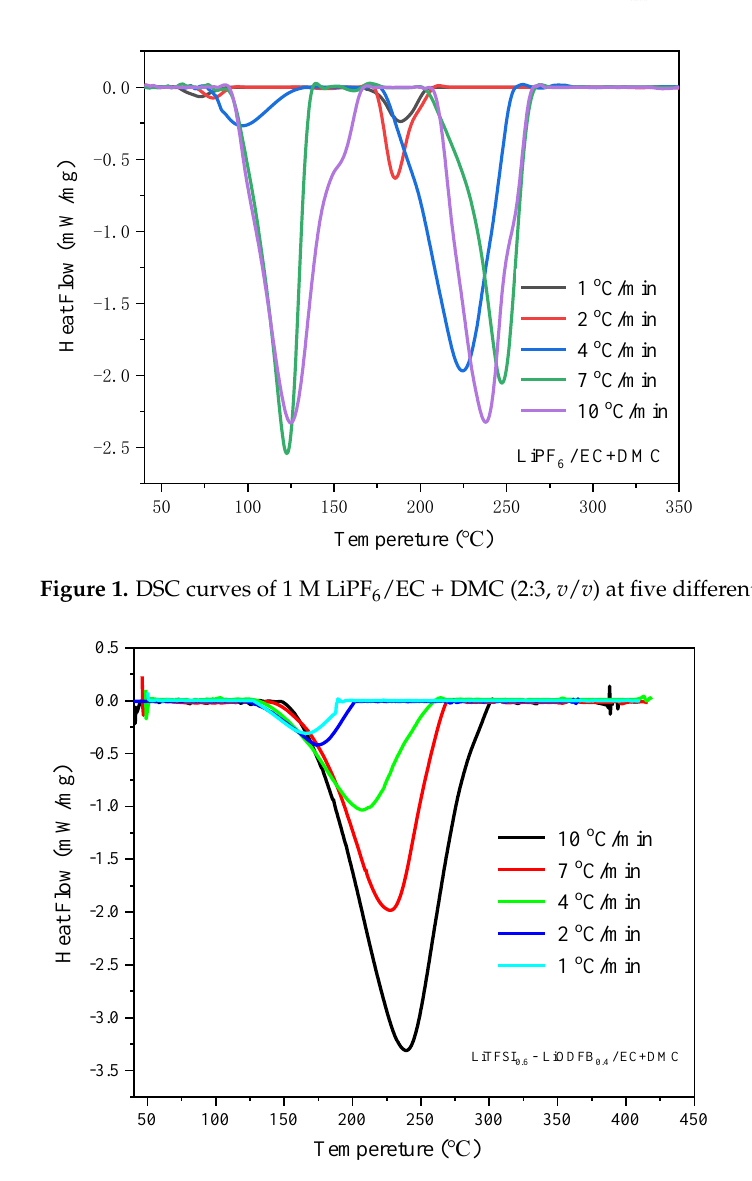
Figure 2. DSC curves of LiTFSI 0.6 -LiODFB 0.4 /EC + DMC (2:3, v/v ) at five different β . Table 2. Characteristic temperature of electrolytes in the DSC experiment at different β .